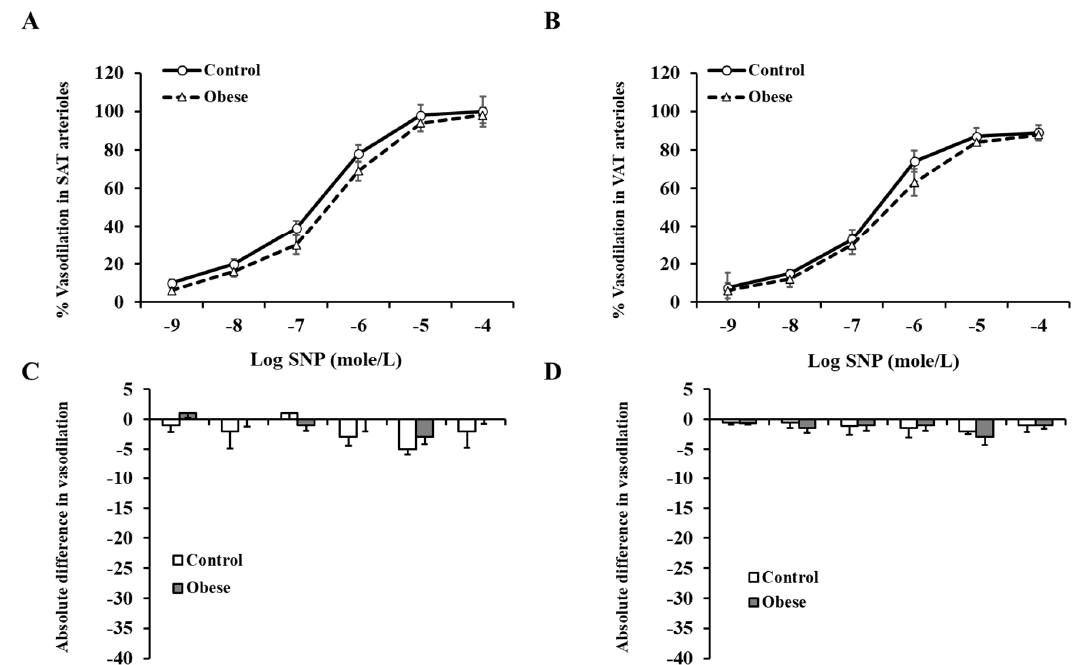
Figure 7. Endothelium-independent vasodilation in SAT and VAT isolated arterioles. The intraluminal diameter of SAT ( A ) and VAT ( B ) isolated arterioles was measured in response to increasing concentrations of SNP (10 − 9 − 10 − 4 M) in obese subjects ( n = 40) and non-obese controls ( n = 40). The absolute difference in SNP-induced vasodilation between Hcy-preconditioned and unconditioned SAT ( C ) and VAT ( D ) arterioles in obese subjects ( n = 10) and non-obese controls ( n = 10). All measurements are presented as means ± standard error (SE).